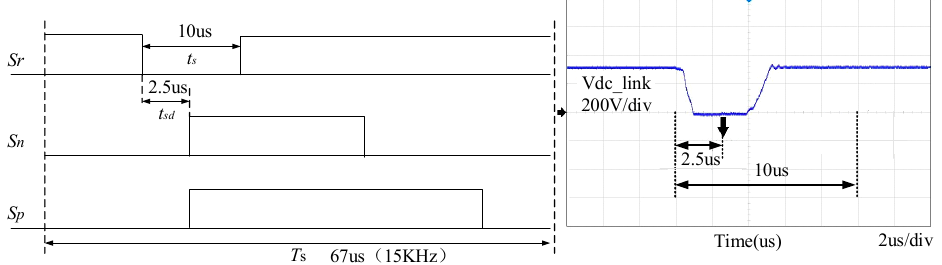
Figure 15. Main switch turned on at zero voltage.